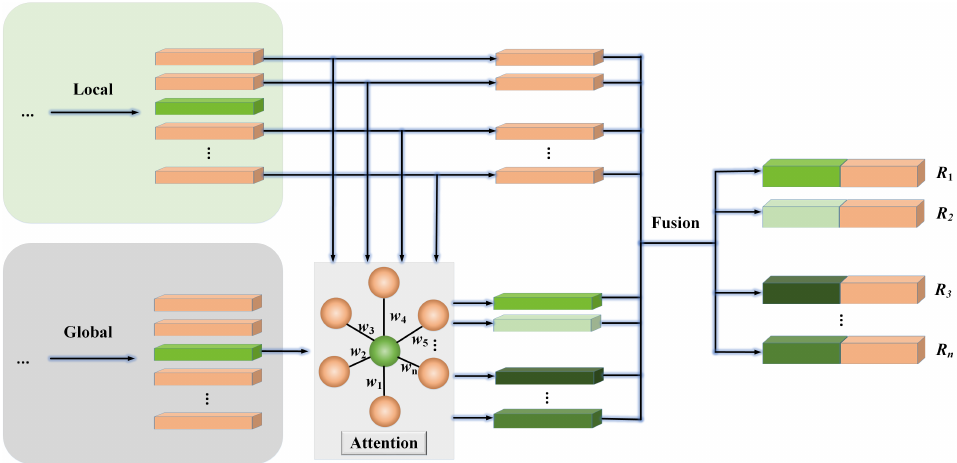
Figure 5. The simplified overall architecture with the extra attention